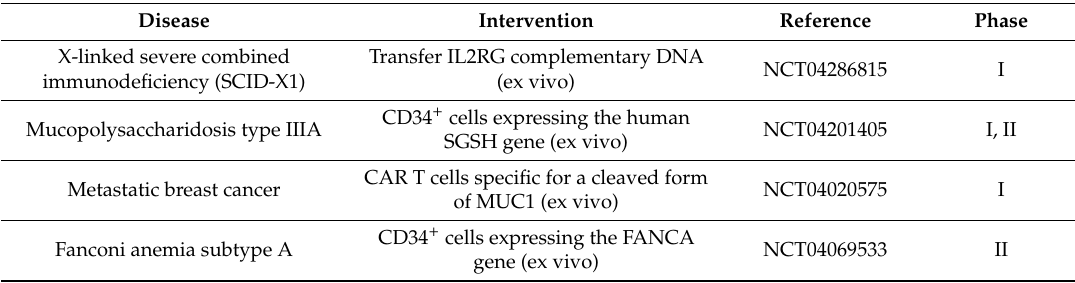
Table 1. Current LV-based clinical trials available from “clinicaltrials.gov” from September 2019 to September 2020 using the terms “Lentiviral vectors” as